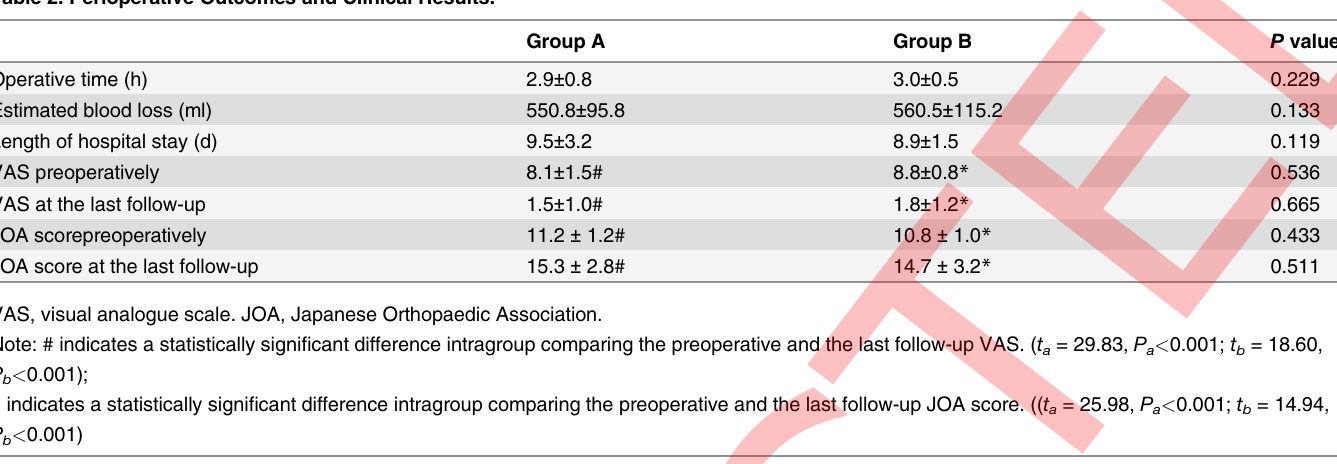
Table 2. Perioperative Outcomes and Clinical Results.